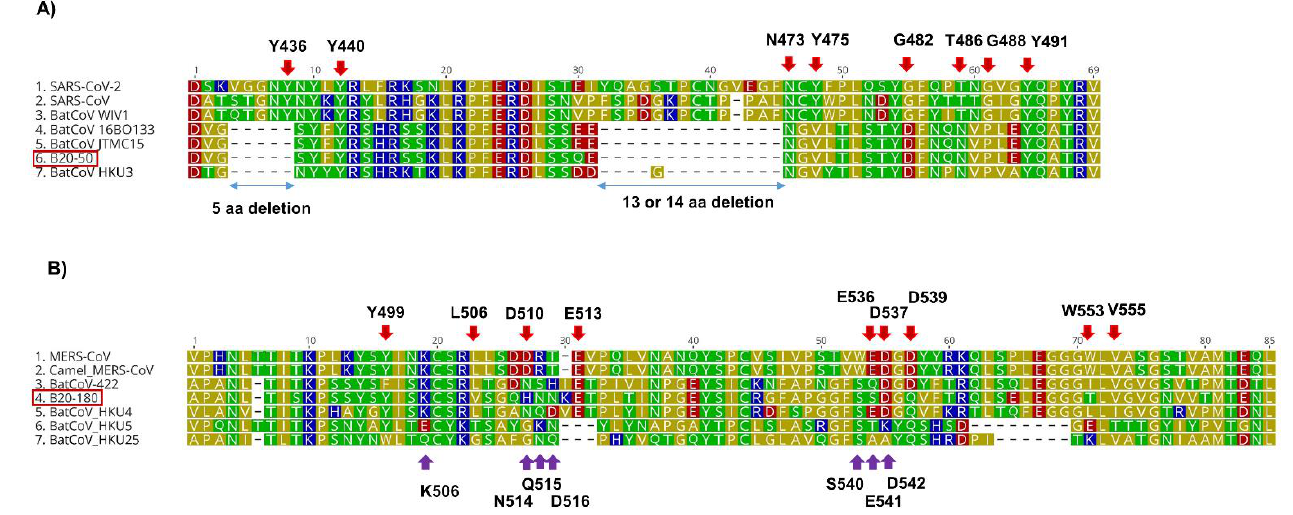
Figure 3. Multiple alignments of the amino acid sequence of the receptor-binding motif (RBM) of the spike protein of SARS-related CoVs ( A ) and Merbecoviruses ( B ). ( A ) Red arrows indicate the position with conserved residues binding between SARS-CoV and SARS-CoV-2 to human angiotensin-converting enzyme 2 (ACE2) in SARS-CoV based on [28]. ( B ) Red and purple arrows indicate the position with conserved residues binding to hDPP4 in MERS-CoV [29] and BatCoV HKU4 [7], respectively. Our sequence name was highlighted in the red box. Amino acid residues were colored by their polarity. Multiple alignments were performed by the MAFFT algorithm in Geneious Prime.